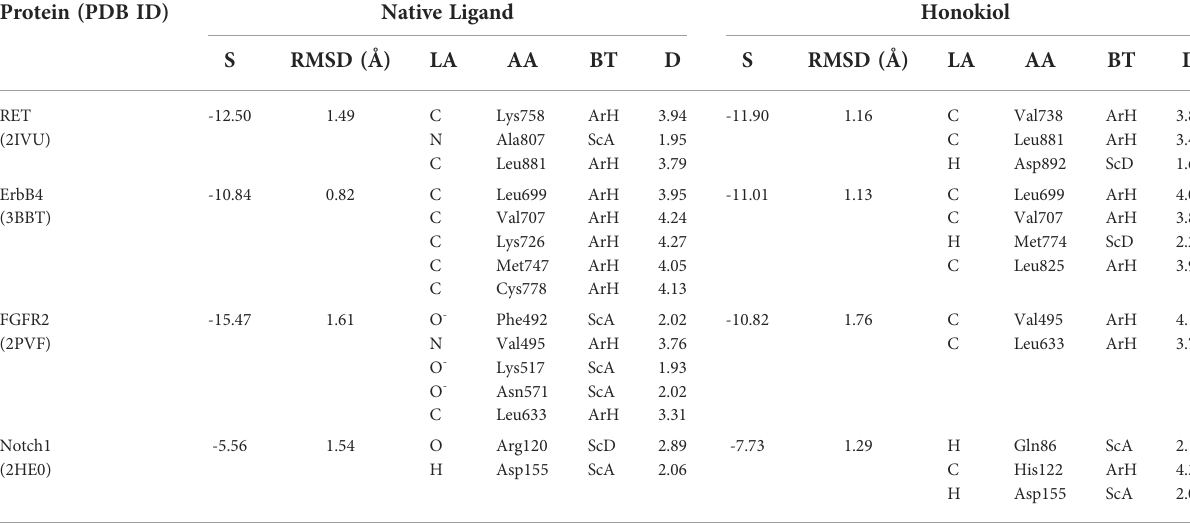
TABLE 5 Molecular docking results of RET, ErbB4, FGFR2, ankyrin domain of NOTCH1, its native ligand, and Honokiol. Protein (PDB ID) Native